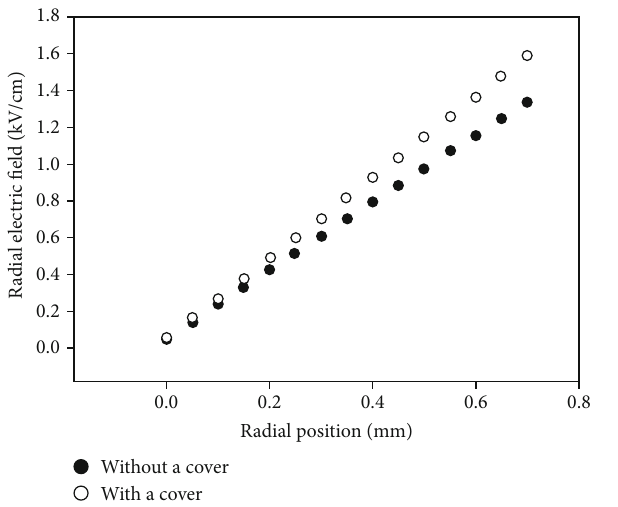
Figure 5: Divergence angle for various accelerator grid